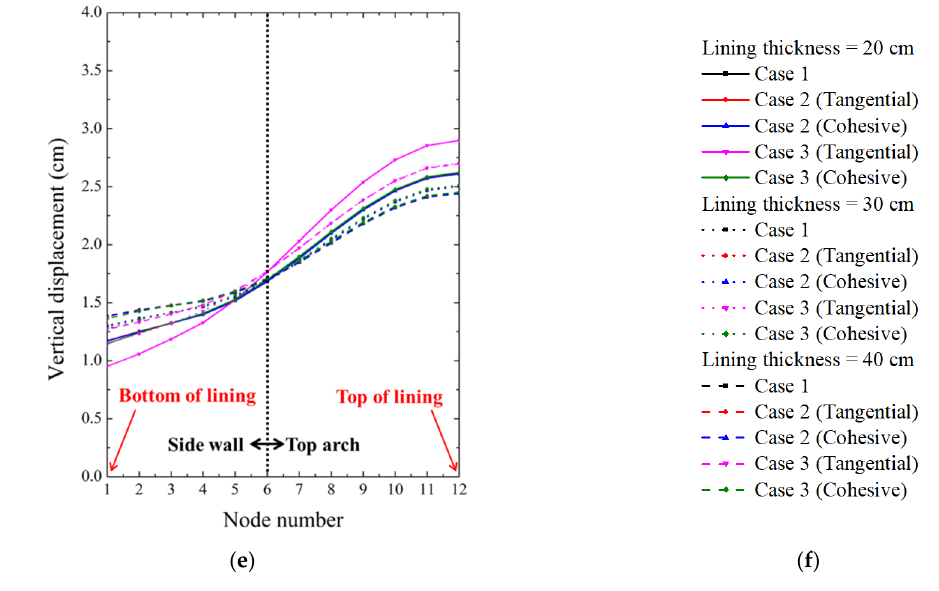
Figure 15. Results for various tunnel-lining cases: ( a ) axial load, ( b ) shear force, ( c ) moment, and ( d ) lateral, ( e ) vertical displacement and ( f ) legend. Table 5. Maximum values of various parameters found in numerical analyses for each case.